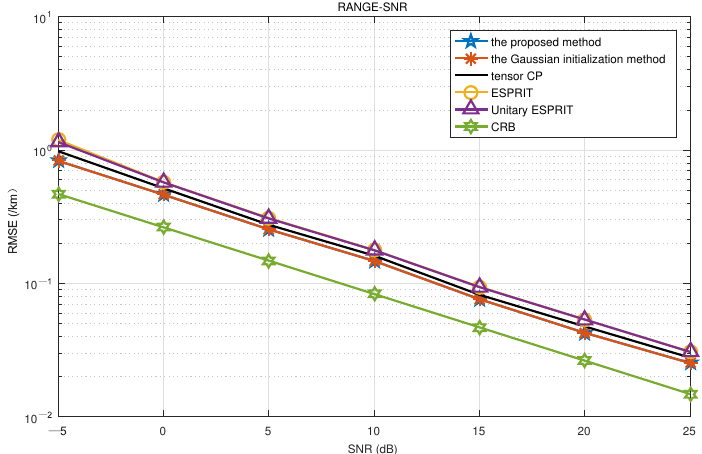
Figure 4. RMSE of range estimation versus